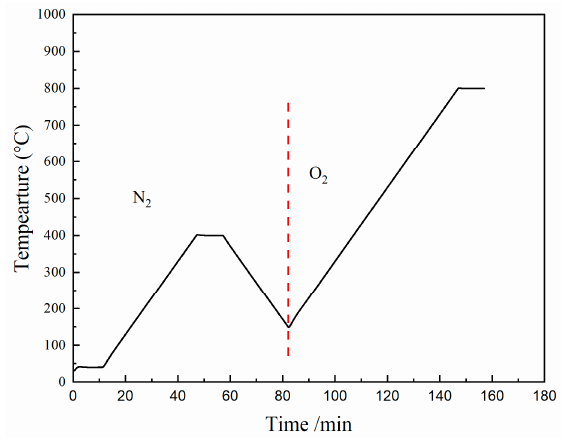
Figure 12. TGA methodology.